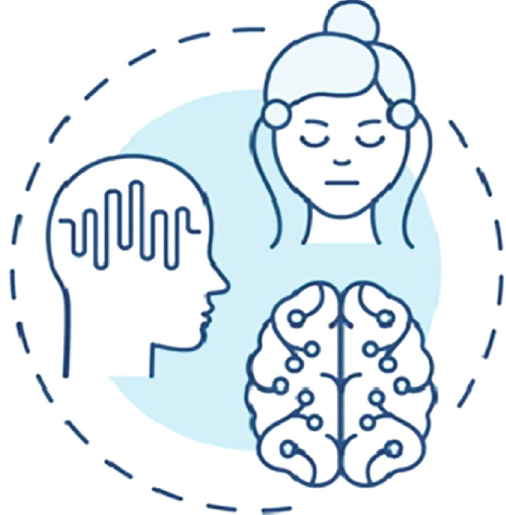
Figure 2: Collection of bioelectrical signals using EEG.